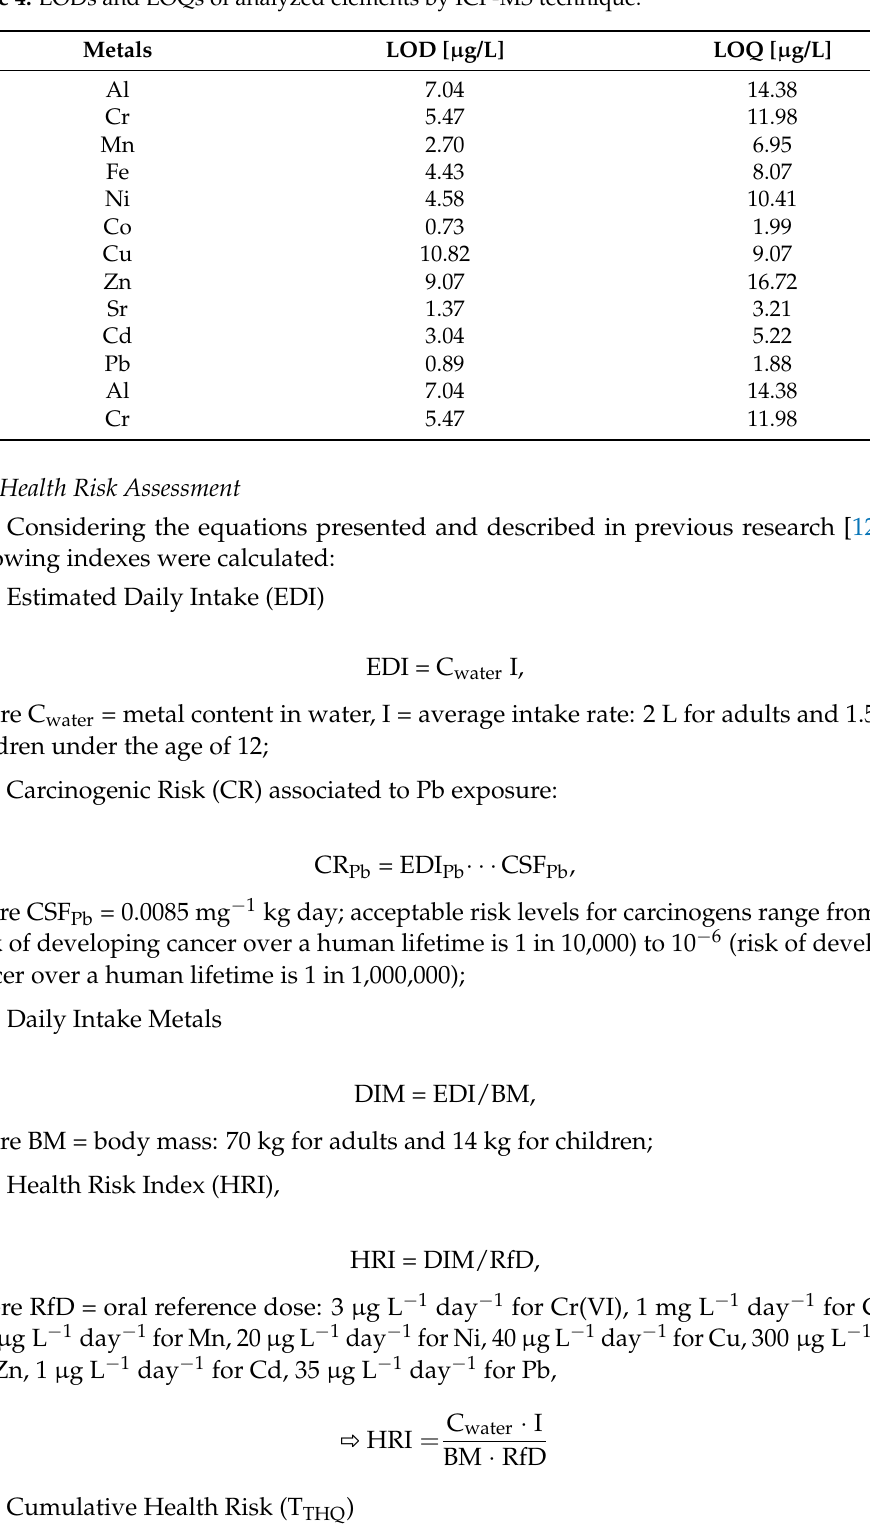
Table 4. LODs and LOQs of analyzed elements by ICP-MS